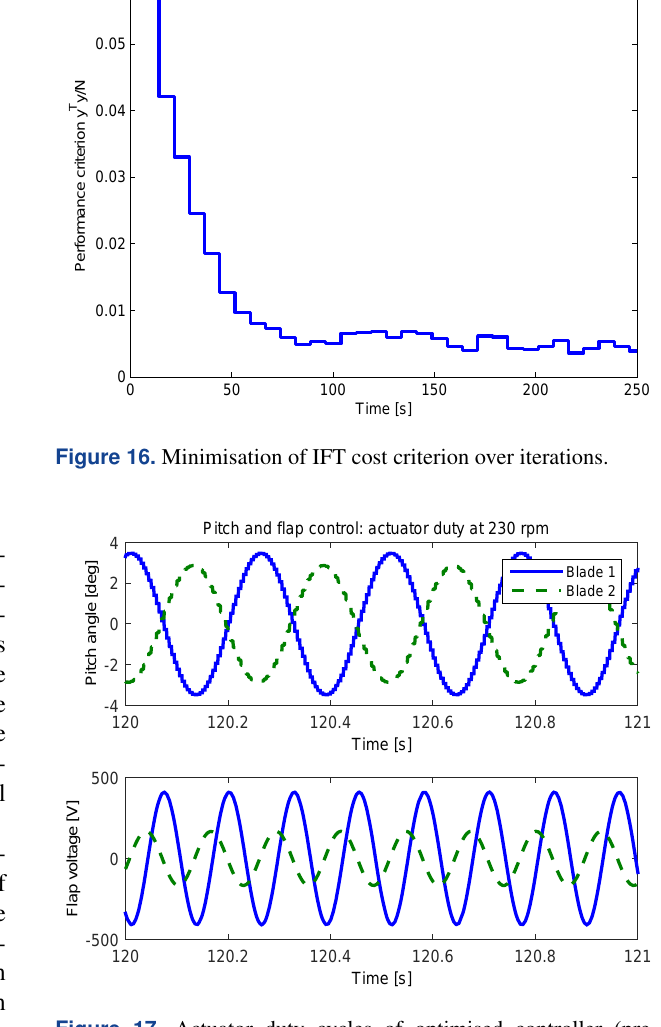
Figure 17. Actuator duty cycles of optimised controller (pre-